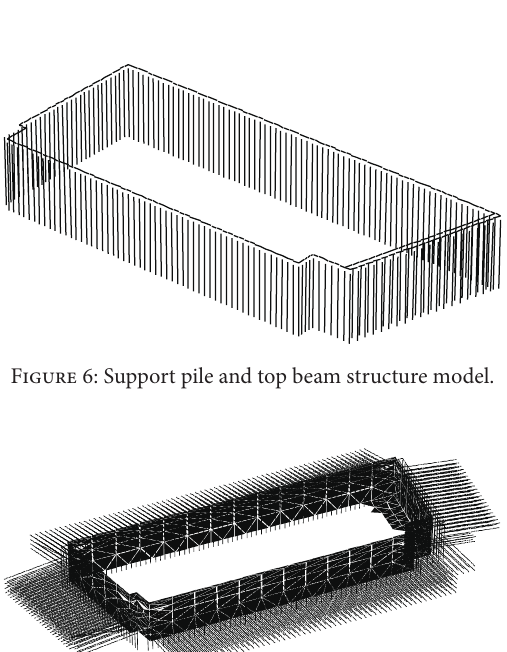
Figure 4: Floor plan of deep foundation pit of Chengdu Museum.